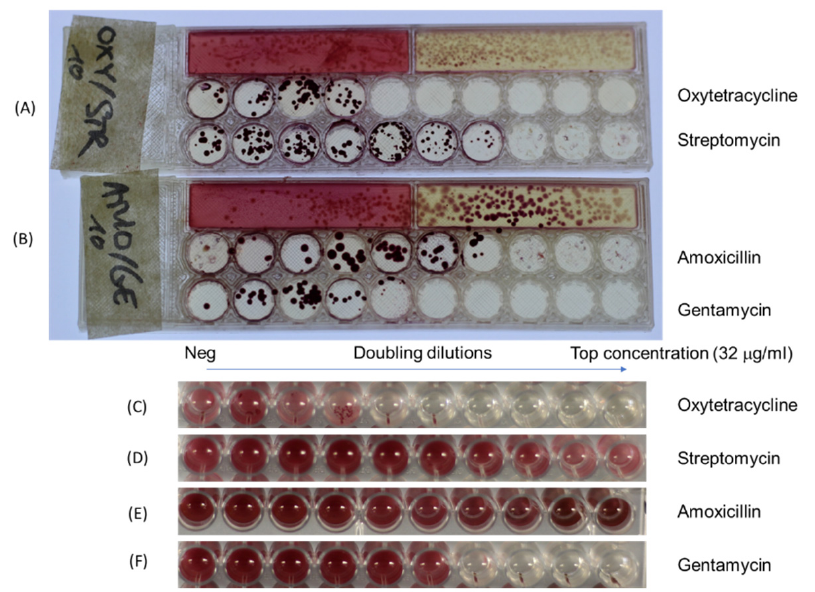
Figure 6. Comparison of frame dip slide and broth dilution methods to determine E. coli isolated from the bovine sample and its MIC . ( A ) The results of dip-slide tests of E. coli on MC/CHROMagar™ Mastitis Gram negative and its MIC for Oxytetracycline and Streptomycin, ( B ) The results of E. coli on MC/CHROMagar™ Mastitis Gram negative and its MIC for Amoxicillin and Gentamycin, ( C ) The results of E. coli on broth microdilution of Oxytetracycline, ( D ) The results of E. coli on broth microdilution of Streptomycin, ( E ) The results of E. coli on broth microdilution of Amoxicillin, ( F ) The results of E. coli on broth microdilution of Gentamycin.